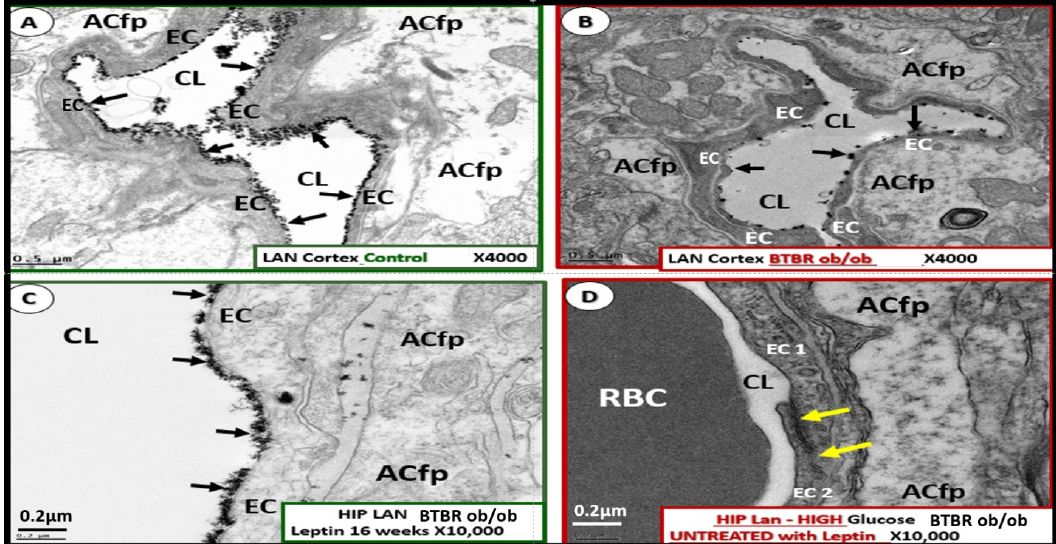
Figure 9. Leptin replacement in the obese diabetic BTBR ob/ob protects the brain endothelial cell glycocalyx (ecGCx) in cortical Layer III and hippocampus . Panel A illustrates the continuous decoration of the ecGCx with lanthanum nitrate (LaN) staining in the heterozygous non-diabetic control model cortical Layer III (arrows). Panel B depicts the marked attenuation and/or loss of the ecGCx in the obese diabetic BTBR ob/ob model cortical Layer III. Note when the ecGCx is present it is clumped and discontinuous (arrows). Panel C also illustrates the continuous decoration of the ecGCx in hippocampus CA-1 regions of the BTBR ob/ob models that were treated with intraperitoneal leptin for 16 weeks and stained with LaN (arrows). The ecGCx is continuous and comparable to the control model in Panel A . Panel D depicts the complete loss of the ecGCx by LaN staining in the hippocampus CA-1 regions of the BTBR ob/ob . Note that the tight and adherens junction (TJ/AJ) remain intact (yellow arrows). Magnification × 4000; scale bar = 0.5 µ m in Panels A and B . Magnification × 10,000; scale bar = 0.2 µ m in Panels C and D . ACfp = astrocyte foot process; Cl = capillary lumen; BEC = brain endothelial cell; HIP and HC = hippocampus CA-1 regions; LAN—LaN = lanthanum nitrate